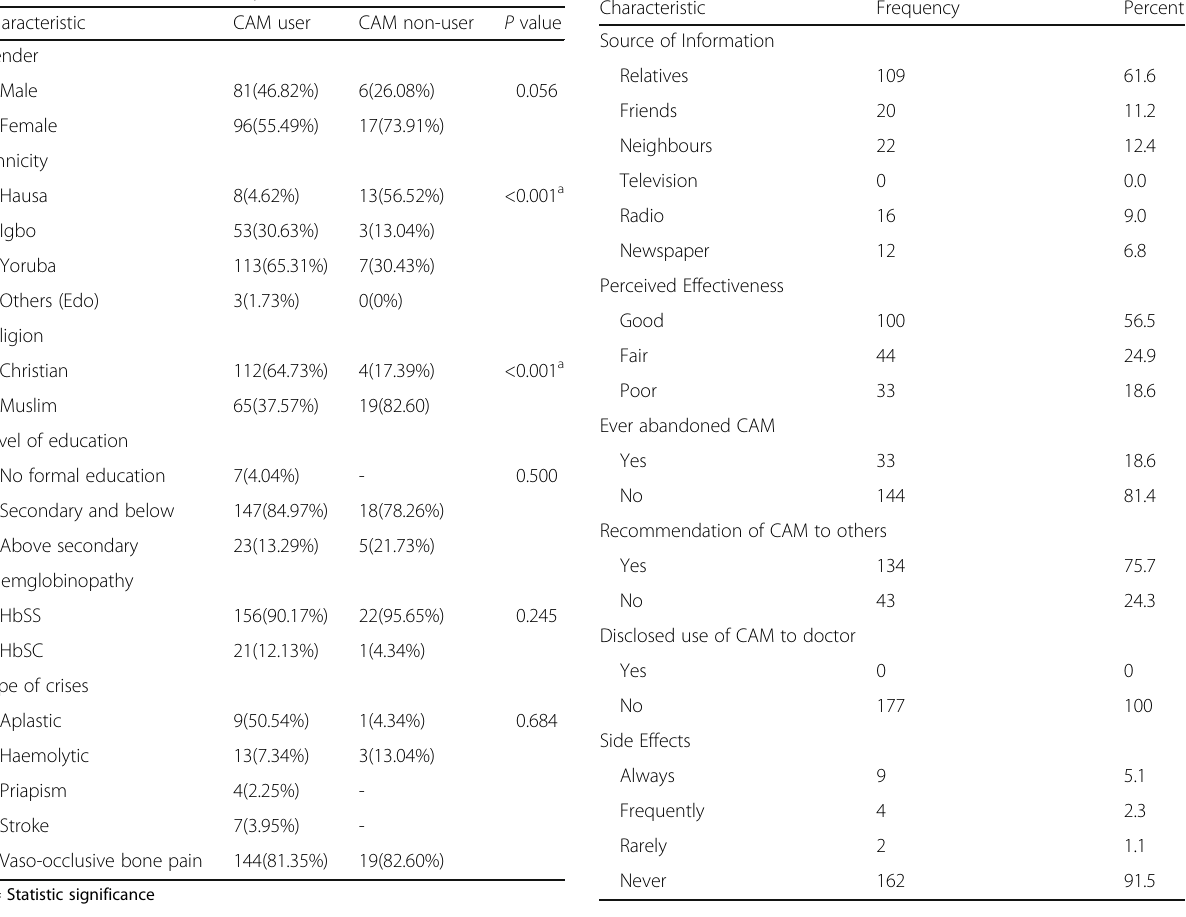
Table 5 Sources of Information, perceived benefit and